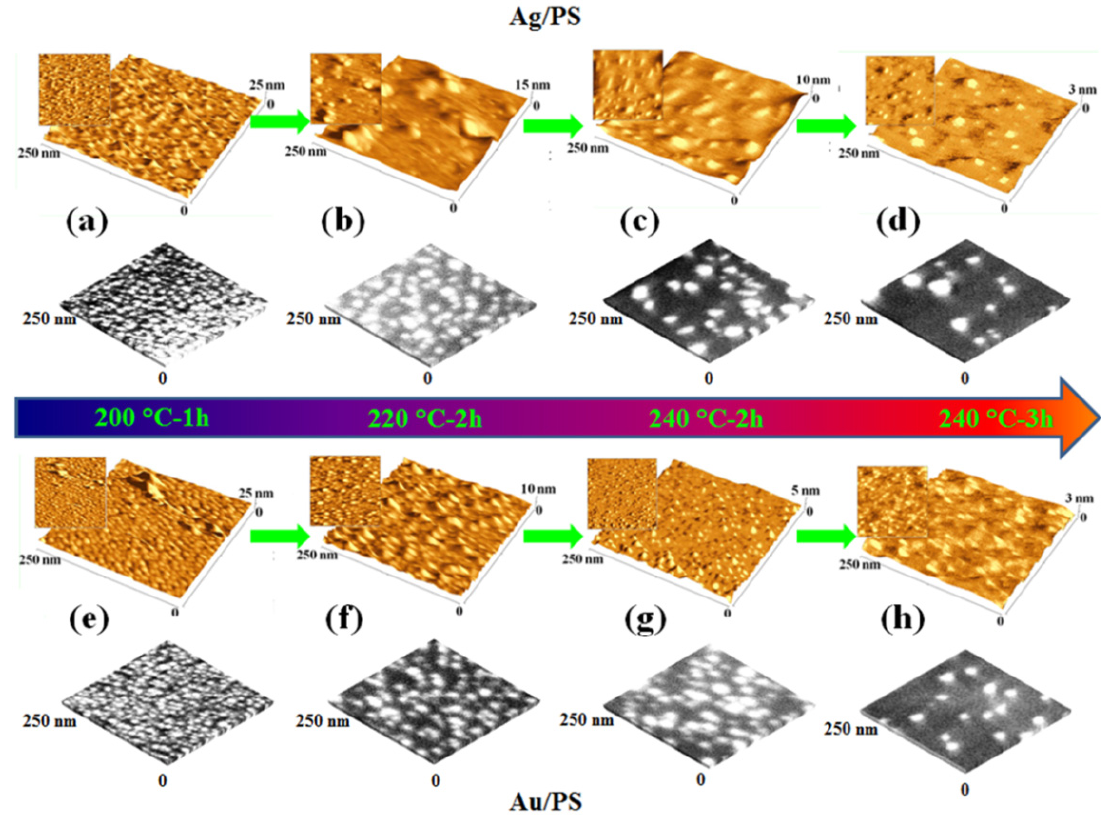
Figure 13. Representative two-dimensional, three-dimensional 0.25 μ m × 0.25 μ m AFM and SEM images of Ag ( a )–( d ) and Au ( e )–( h ) films deposited on PS and annealed for various temperatures and times. (Reproduced with permission from [65], Copyright Springer